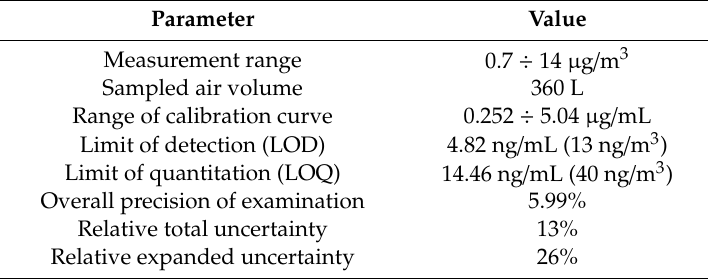
Table 5. Validation parameters of the method for PS